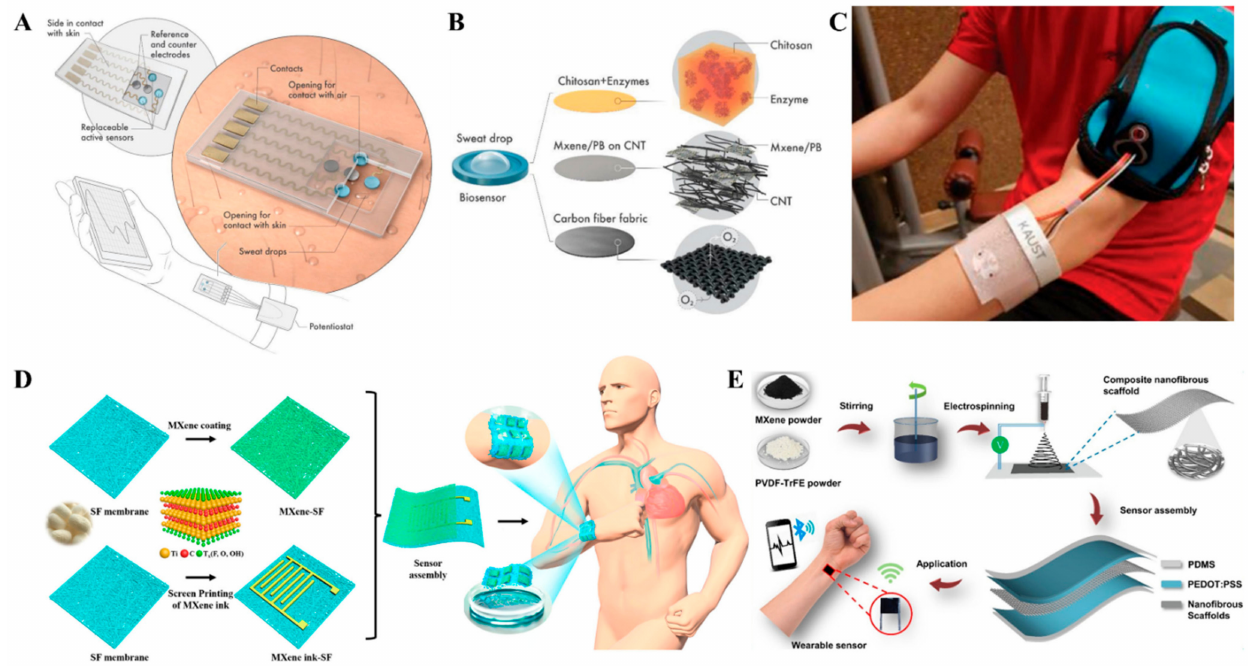
Figure 6. ( A ) Schematic illustration of the MXene/Prussian blue-based wearable perspiration analysis system. ( B ) Oxygen-rich enzyme electrode. ( C ) Digital photograph of the wearable sensor patch on the skin connected to a portable electrochemical analyzer. Reproduced with permission from Ref. [130]. Copyright © 2019 Wiley. ( D ) Schematic illustration of the fabrication of MXene/protein nanocomposite-based breathable and degradable pressure sensor. Reproduced with permission from Ref. [132]. Copyright © 2021 American Chemical Society. ( E ) Schematic illustration of the